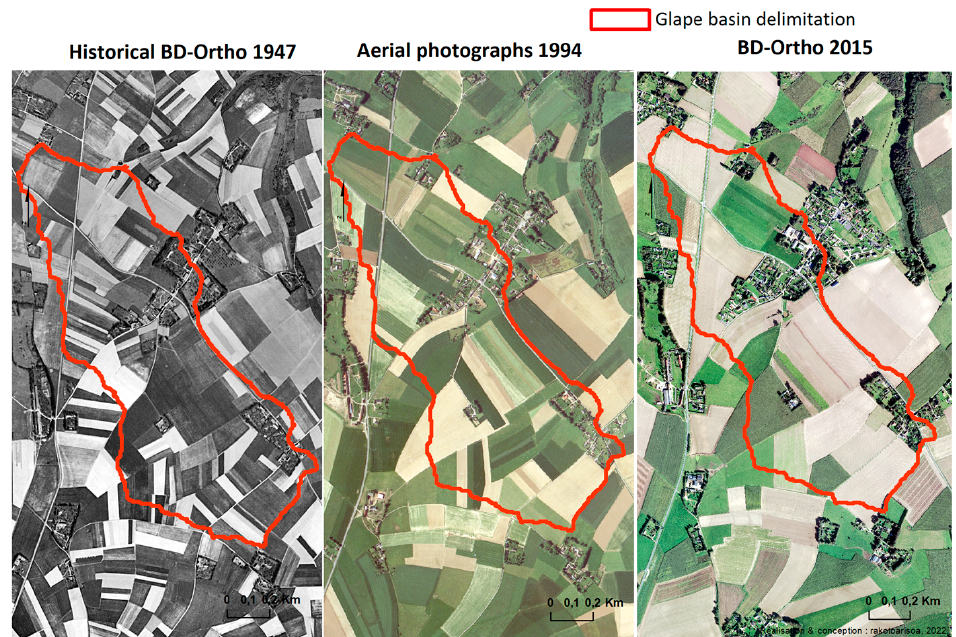
Figure 3. Images used to identify the evolution of the landscape structure in the Glape basin.